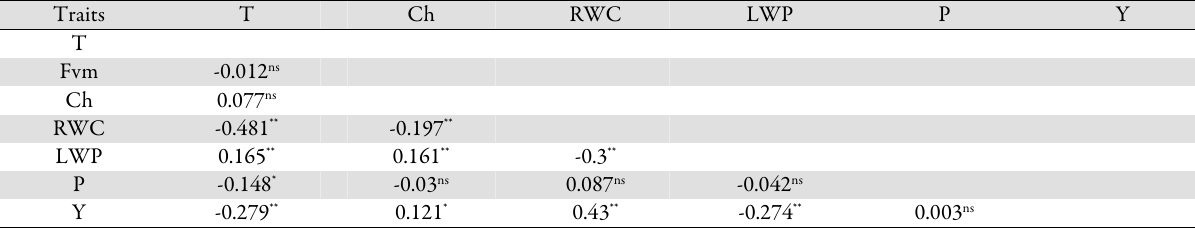
Tab. 5. Correlation between traits i.e. canopy temperature (T), chlorophyll content (Ch), relative water content (RWC), leaf water potential (LWP), proline content (P) and yield